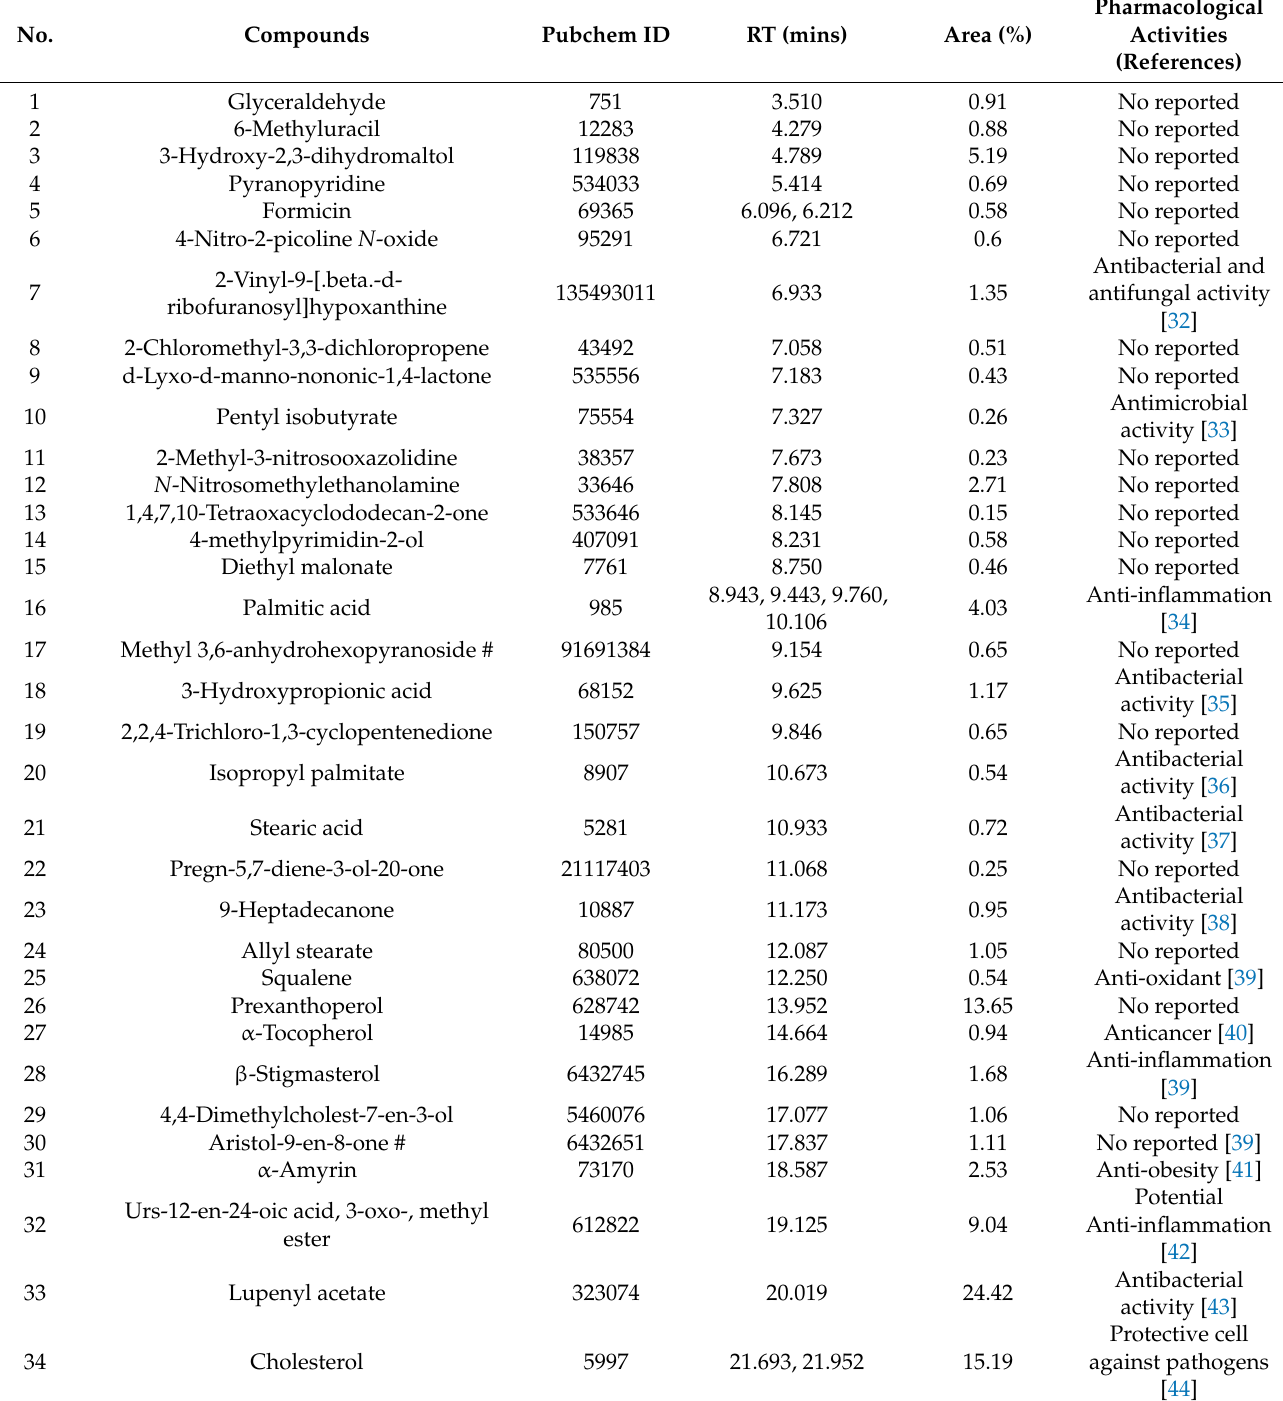
Table 1. A list of the 34 bioactives identified from C. maackii through GC-MS and profiling of bioactivities.